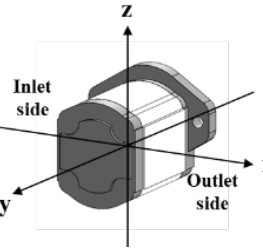
Figure 20. Coordinate system for the SPL distribution in Figure 21.